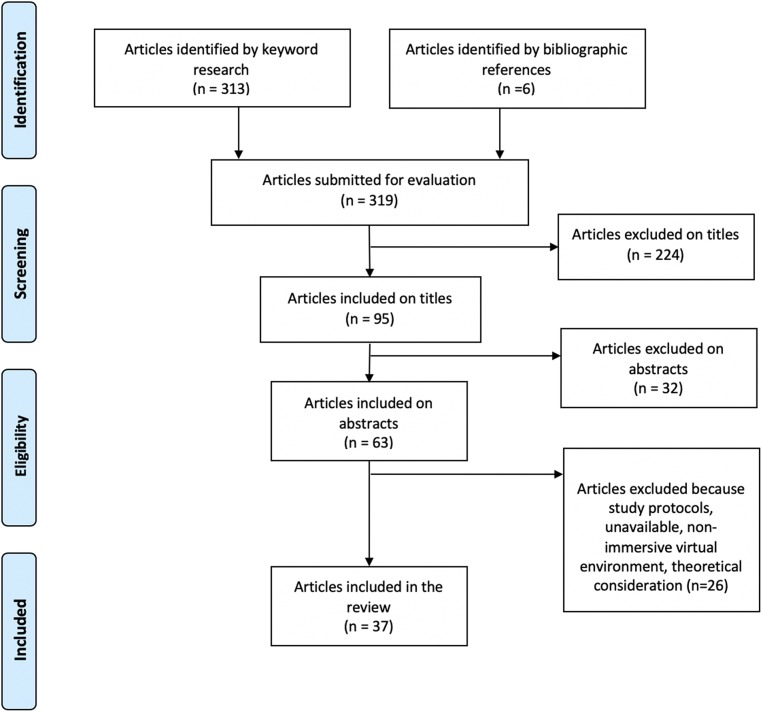
PRISMA flow diagram.